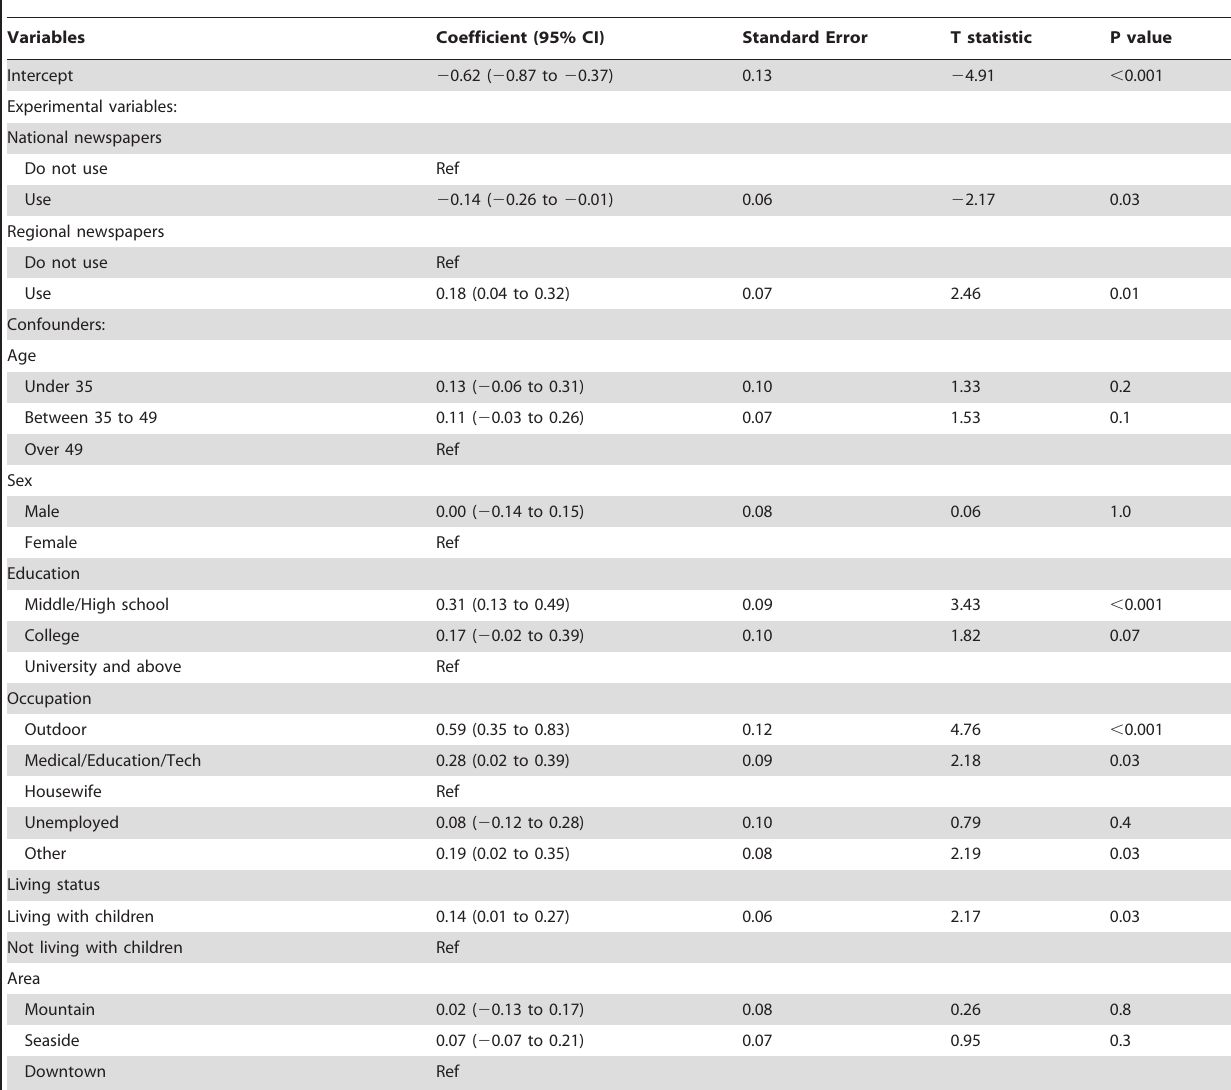
Table 4. Multiple regression model of factor two against the media